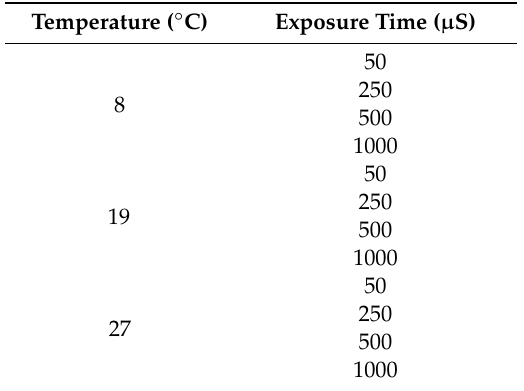
Table 3. The factorial design of experiment studying the e ff ects of the ambient temperature and exposure time on the amount of image noise as a main user-controllable sources of noise in